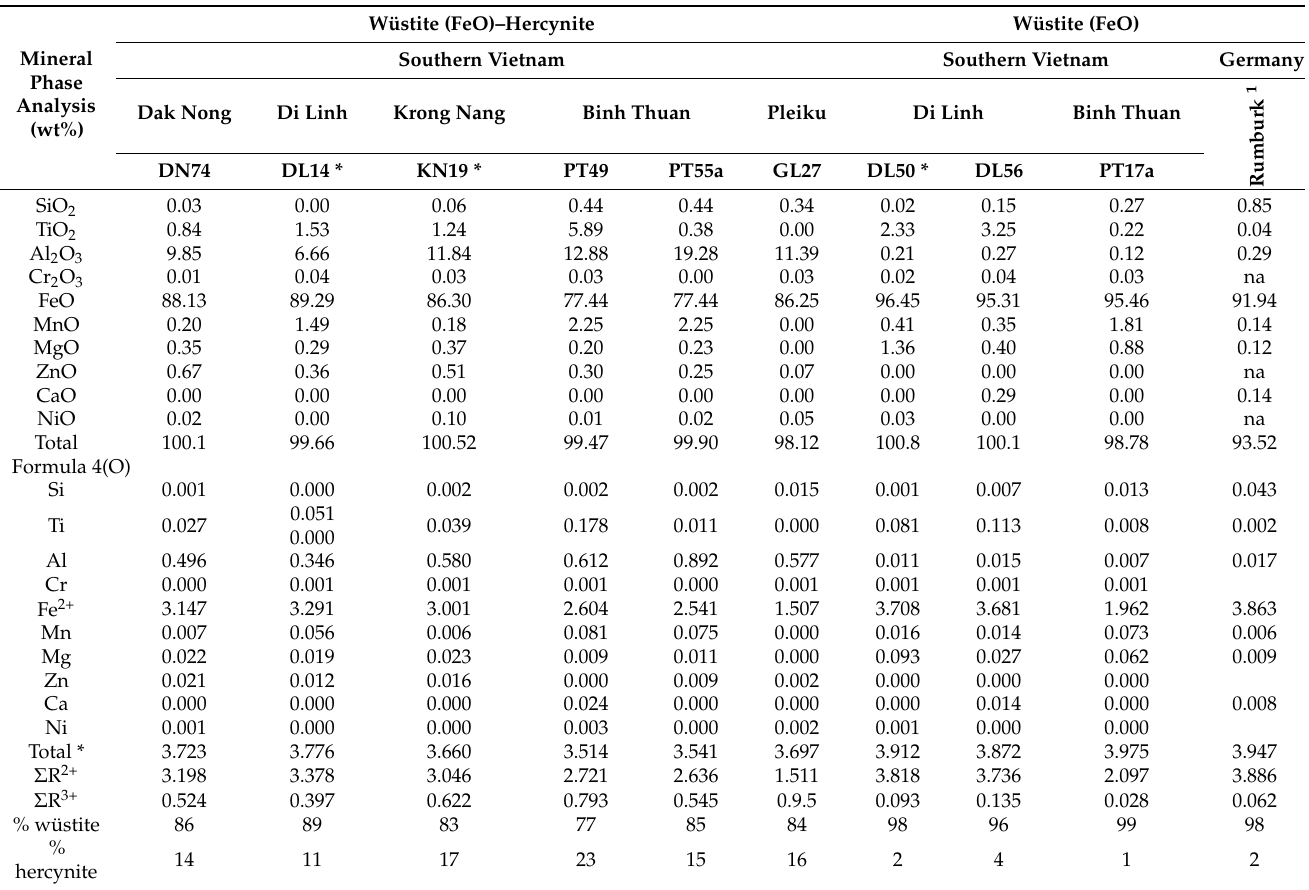
Table 1. Representative EPMA analyses of wüstite inclusions in sapphire from Southern Vietnam.